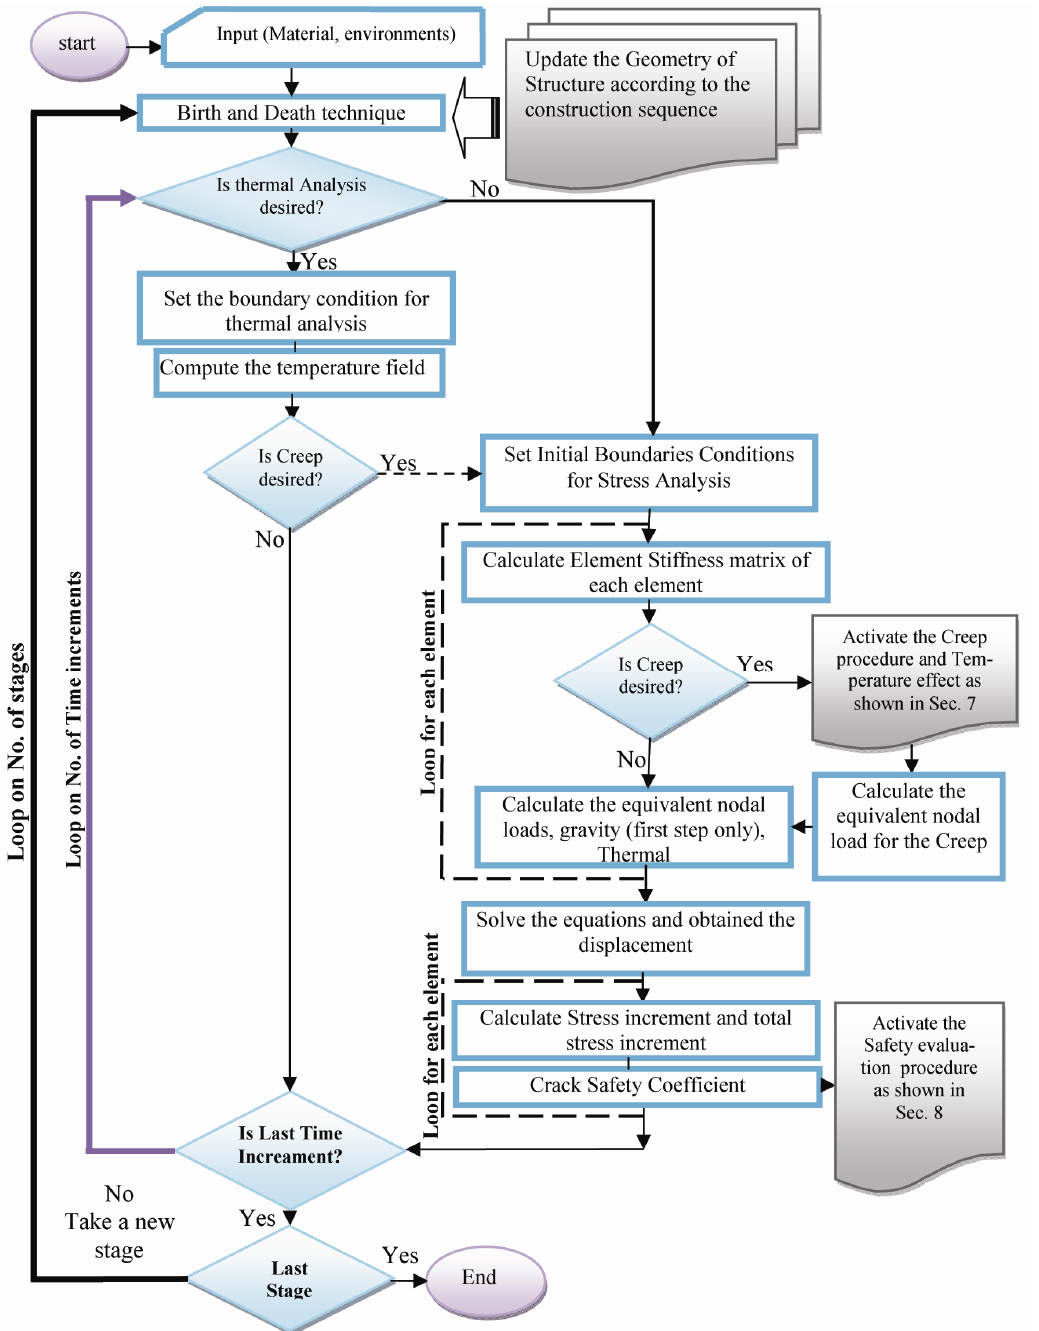
Fig. 1. Program flow chart of the computer code (with temperature and creep modification)